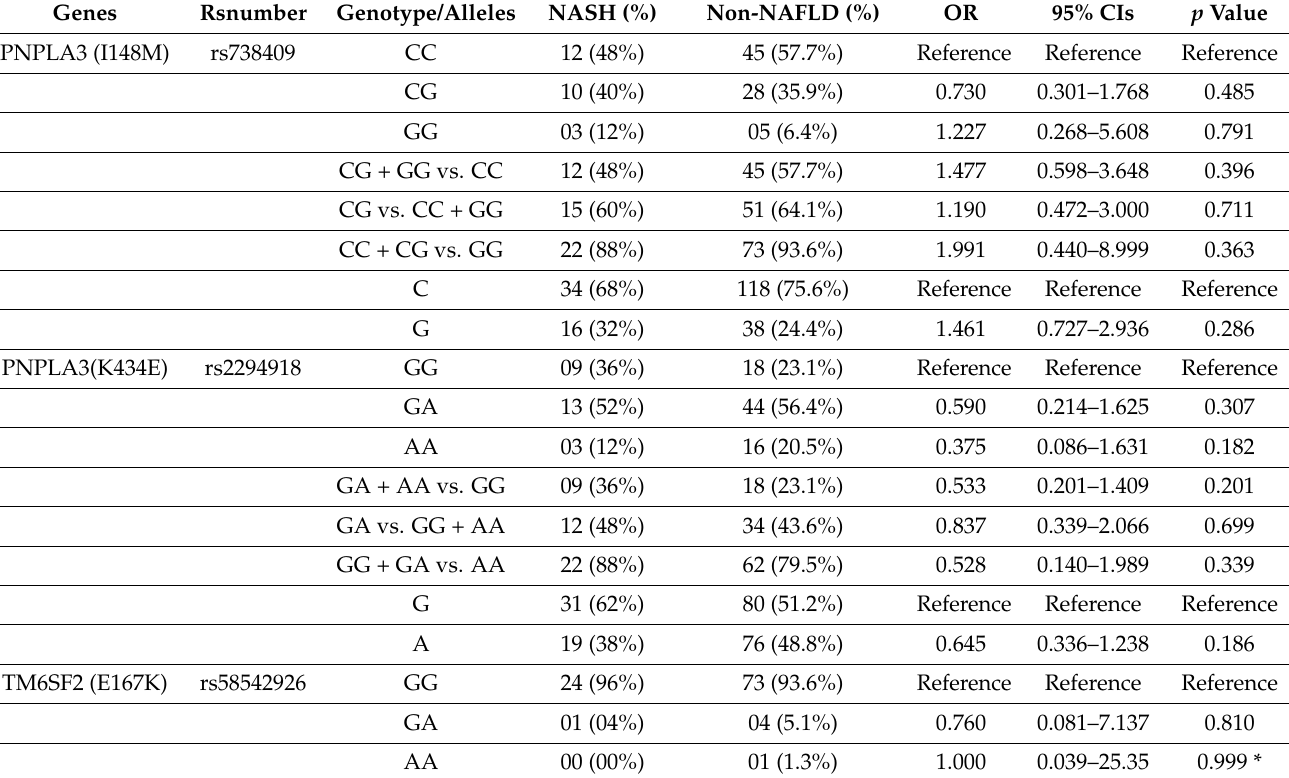
Table 5. Genotype frequencies with various modes of inheritance in the NASH and non-NAFLD groups.